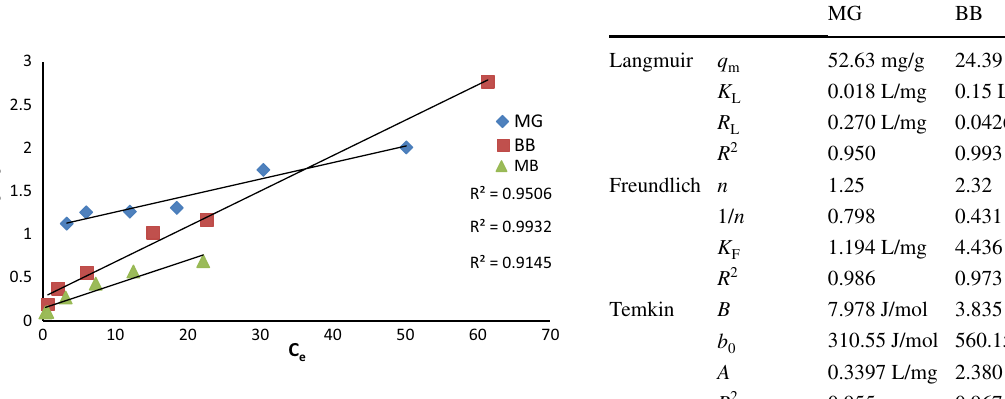
Fig. 6 Langmuir adsorption isotherm for Zn(II)